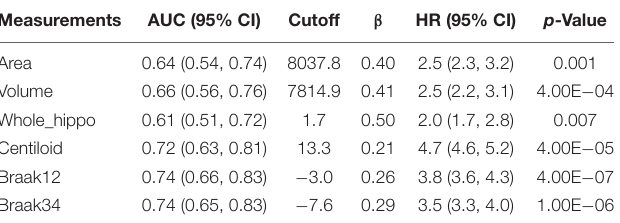
FIGURE 8 | The ROC analysis results for hippocampal surface area, volume, the whole hippocampal feature, and the features on ROIs associated with A β , Braak12, and Braak34. The AUC for each measurement is shown in parentheses. TABLE 4 | AUC for ROC analysis, optimal cutoffs, and estimated hazards ratios (HRs) for conversion to AD in MCI patients with high-value and low-value biomarkers based on a univariate Cox